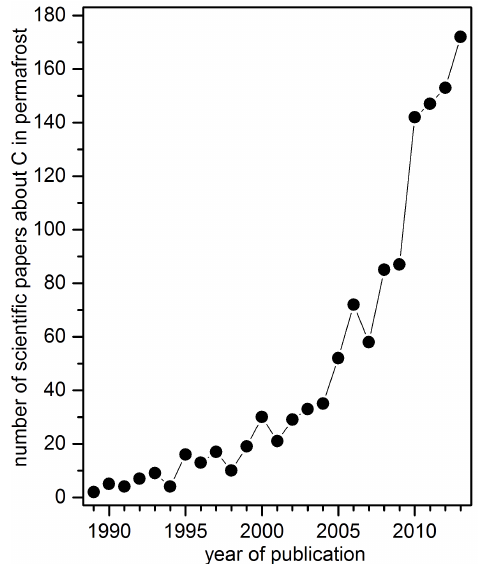
Figure 9. Number of scientific papers published between 1989 and 2013 as a result of a search for the keywords “permafrost + car- bon” in Web of Science (www.webofknowledge.com) on 14 Jan- uary 2014.